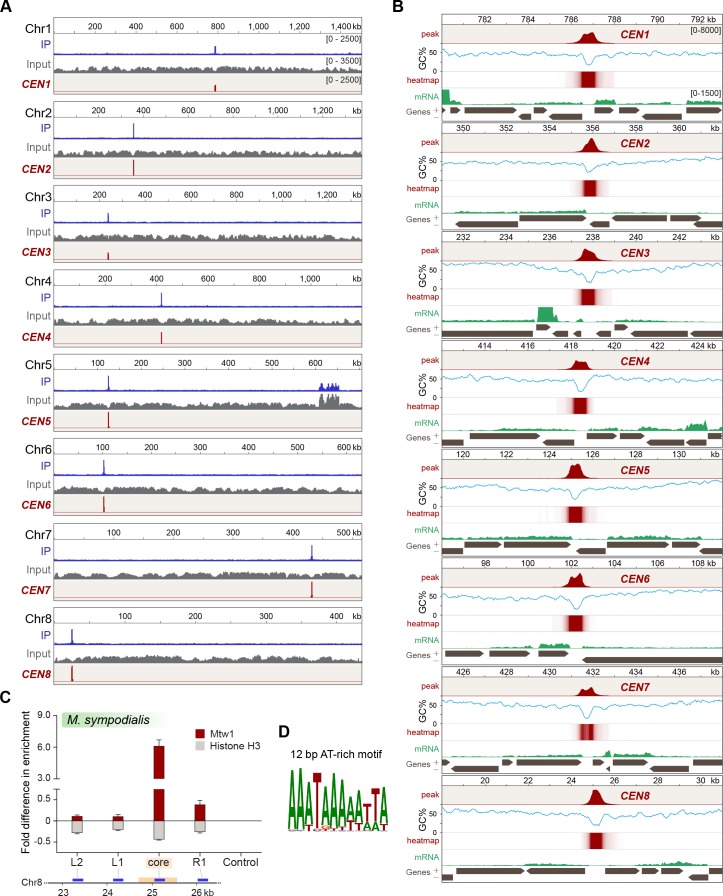
Localization of Mtw1 to single-peaks identifies centromeres on each of the eight chromosomes of M. sympodialis.(A) GFP-Mtw1 ChIP-seq reads were mapped to each chromosome. The x-axis indicates chromosomal coordinates (in kb) and the y-axis indicates read depth. ‘Input’, reads from total DNA; ‘IP,’ reads from immunoprecipitated sample; CEN, Mtw1-enriched regions derived by subtracting input reads from those of the IP sample (peak values 0–2500). Additional peaks observed in both IP and input tracks on Chr5 are from the rDNA locus. (B) A 13 kb-window of the Mtw1 enrichment profile (CEN, represented as peaks and heat-map in two different tracks, red) plotted along with the GC content (%GC, blue) and regions of transcription (RNA-seq, green). Numbers in the topmost track in every panel indicate chromosomal coordinates (in kb). The scales for the y-axis are as follows: CEN (0–8000), %GC (0–75), RNA-seq reads (0–1500). Gray arrows in each panel indicate predicted ORFs based on RNA-seq data with arrowheads indicating the direction of transcription of the corresponding gene, also marked as ‘+’ and ‘–’ in the axis label. (C) Fold difference in Mtw1 and histone H3 enrichment at CEN8, as compared to a non-centromeric control region (190 kb away on the right of CEN1) by qPCR analysis. Schematic of a 4-kb region of Chr8 with the CEN8 core (yellow box) is depicted below the graph. Blue lines indicate regions assayed by PCR: core-region corresponding to the GC trough; L1 and R1, 750 bp away from the core; L2, 1500 bp away from the core; and a non-centromeric control region (190 kb away from centromere in Chr1). The x-axis indicates regions across the CEN8 probed by PCR and the y-axis indicates fold difference in the enrichment of Mtw1 and histone H3 as compared to the control region. Error bars indicate standard deviations (SD). Values from three experiments, each performed with three technical replicates, were used to generate the plot. (D) Logo of the consensus DNA sequence identified from M. sympodialis centromeres, graphically represented with the size of the base corresponding with the frequency of occurrence.Figure 3—source data 1.Source raw data for Figure 3C (ChIP-qPCR for GFP-Mtw1 and Histone H3 across MsyCEN8).